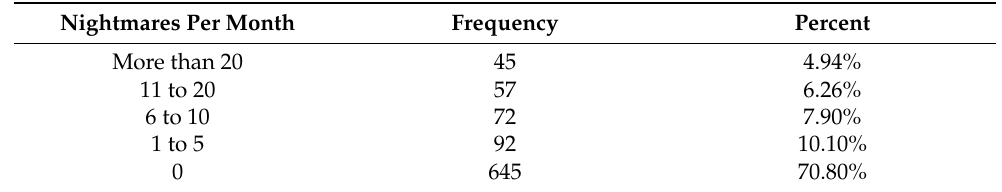
Table 3. Distribution of nightmare frequency ( n = 911).